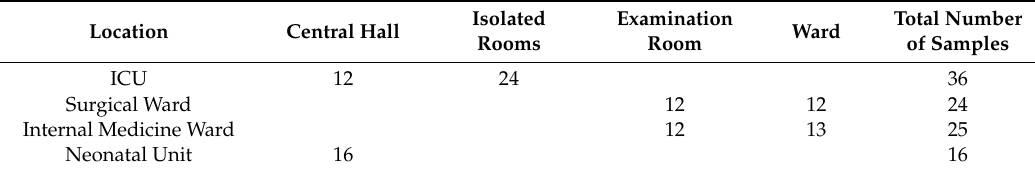
Table 1. Location of air sampling.